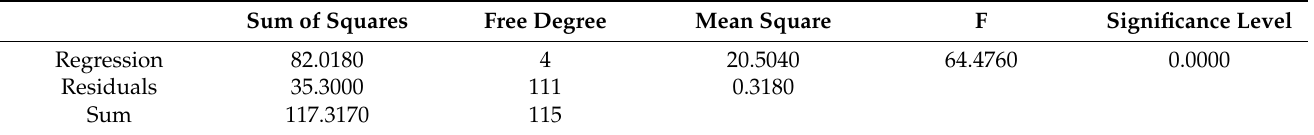
Table 3. Variance analysis of the MTSV CQ in summer.